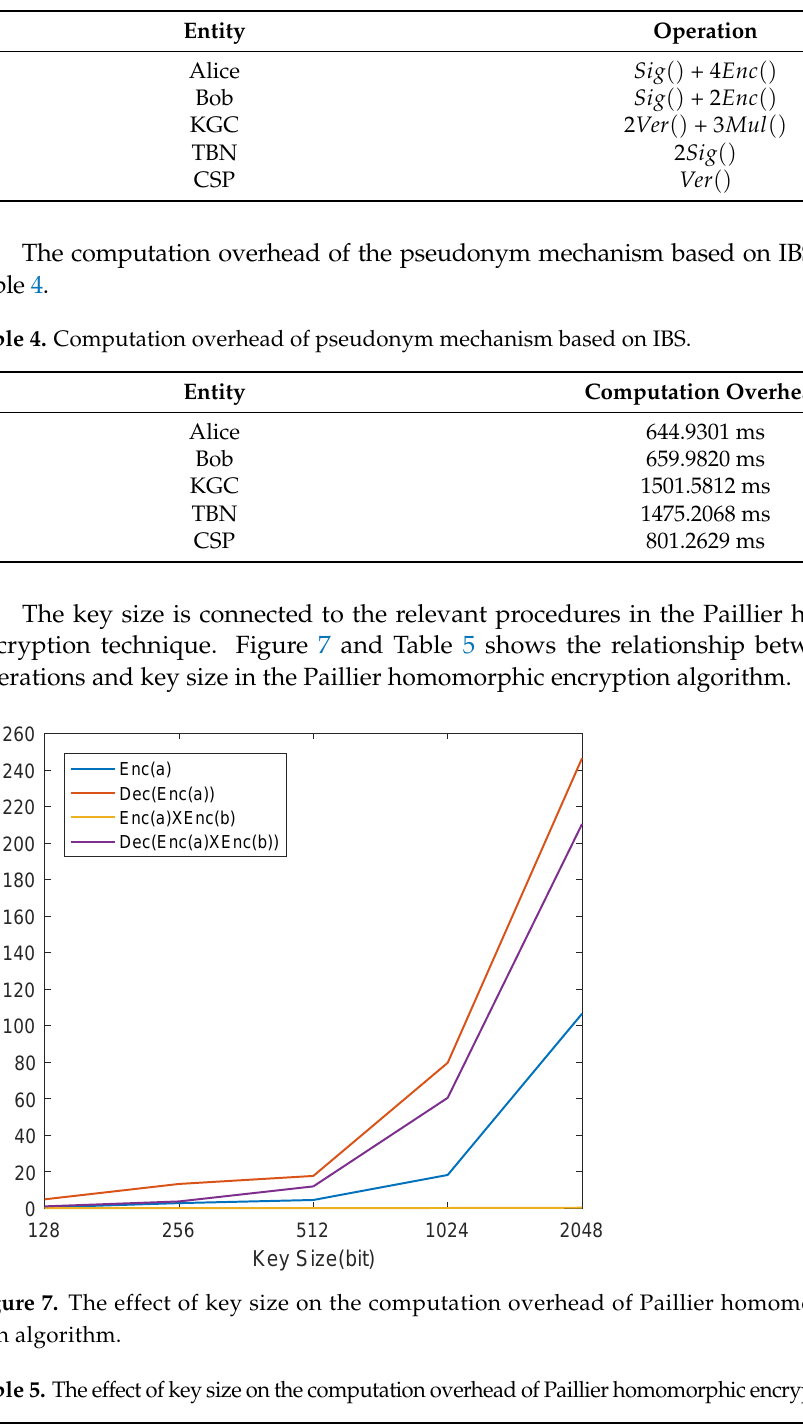
Table 3. Main operations of the proposed scheme.